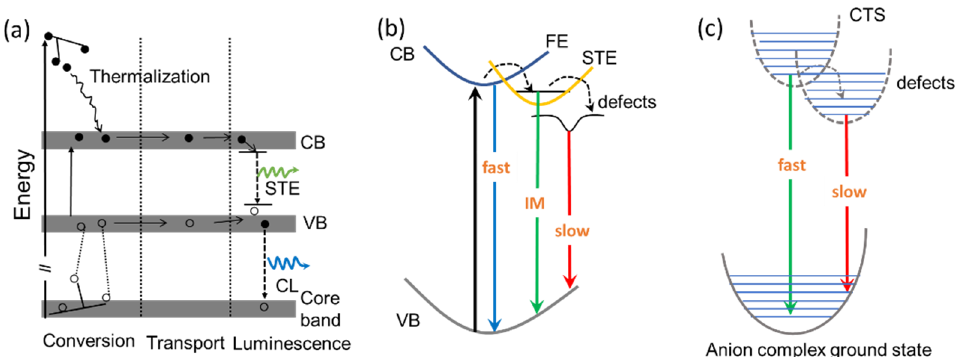
Figure 1. ( a ) Schematic of the scintillator mechanism (STE: self-trapped excitons; CB: conduction band; VB: valence band; CL: cross luminescence; after Nikl [15] with permission). ( b ) Diagram illustrating the coexistence of free exciton (FE), self-trapped exciton (STE) and deep-level defects for fast, intermediate (IM) and slow decay. ( c ) Excited charge-transfer state (CTS) of an anion complex for fast and slow decay.